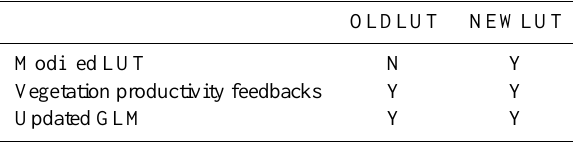
Table 1. Two iESM simulations performed for this